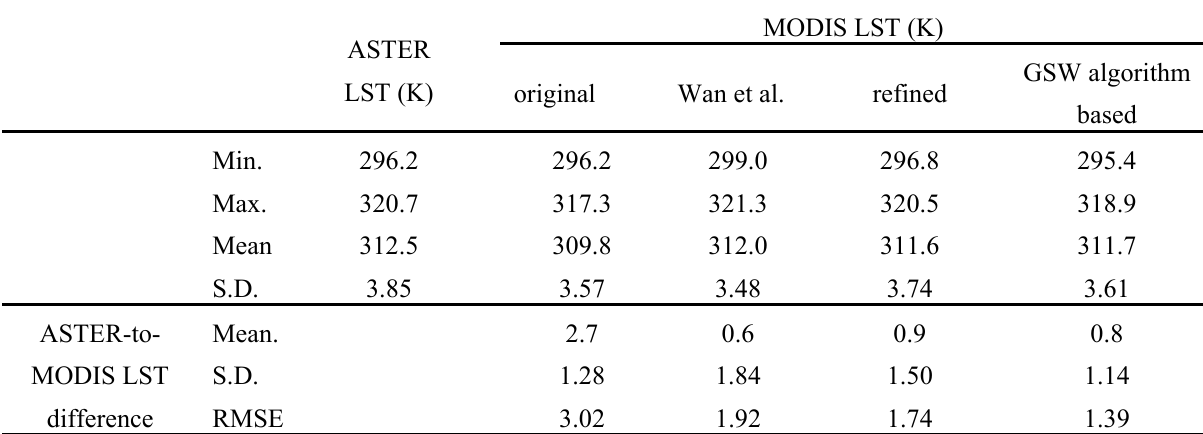
Table 1. Comparison of the MODIS LST (original and corrected by three approaches) with reference to the ASTER LST, without correction for terrain